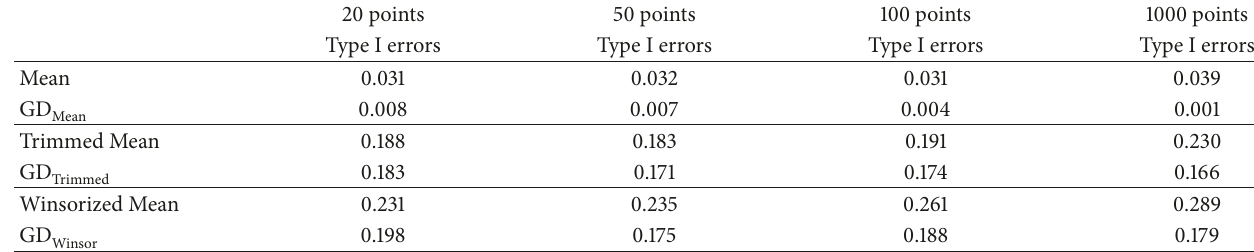
Table 68: G-h distributions with 50% noise level.